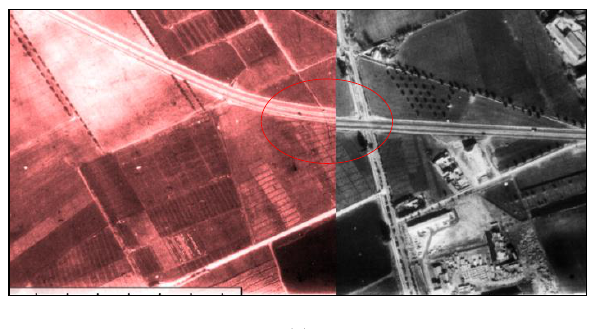
Table 2. Transformation